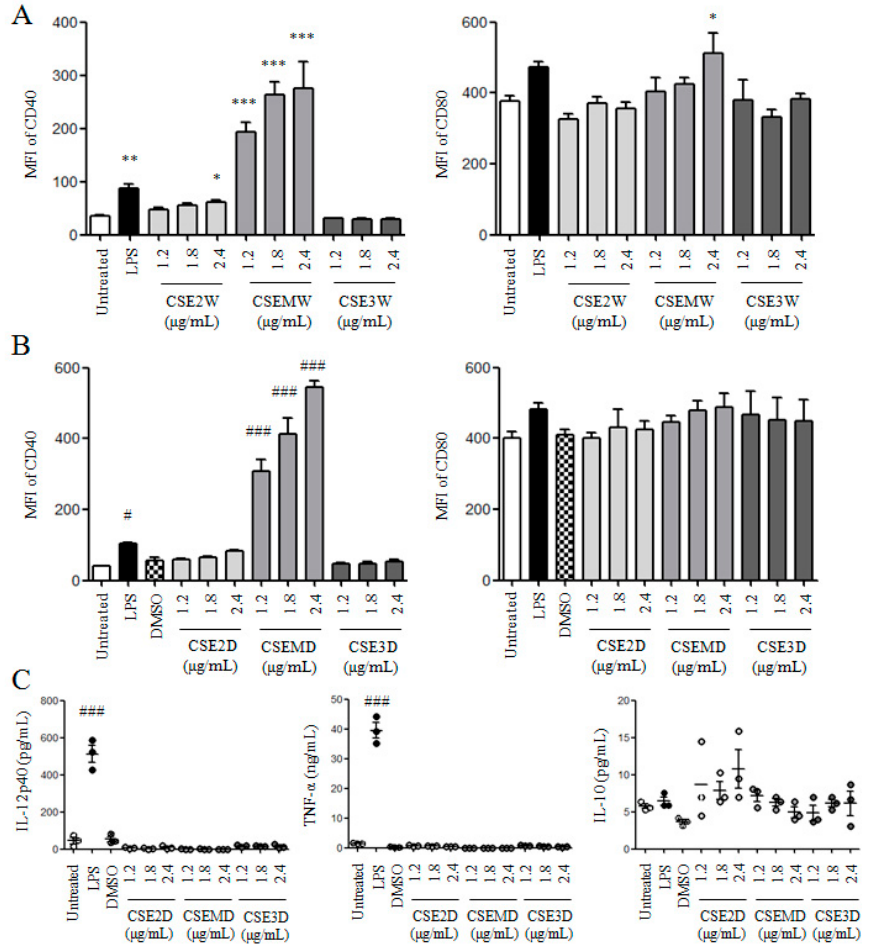
Figure 4. The effect of flavonoids in CSEs on DC maturation. DCs were treated with different concentrations of flavonoids in CSEs for 12 h. Cells were collected to analyze the expressions of CD40 and CD80 by flow cytometry. ( A ) MFI of CD40 and CD80 upon CSE2W, CSEMW and CSE3W treatment; ( B ) MFI of CD40 and CD80 upon CSE2D, CSEMD, and CSE3D treatment; ( C ) The supernatants were collected to detect the levels of IL-12p40, IL-10, and TNF- α by ELISA after CSE2D, CSEMD, and CSE3D treatment. The concentrations of IL-12p40, IL-10, and TNF- α are shown. Data are from four independent experiments and analyzed by ANOVA. * p < 0.05; ** p < 0.01; *** p < 0.001 compared to untreated DCs. # p < 0.05; ### p < 0.001 compared to DMSO treated DCs.